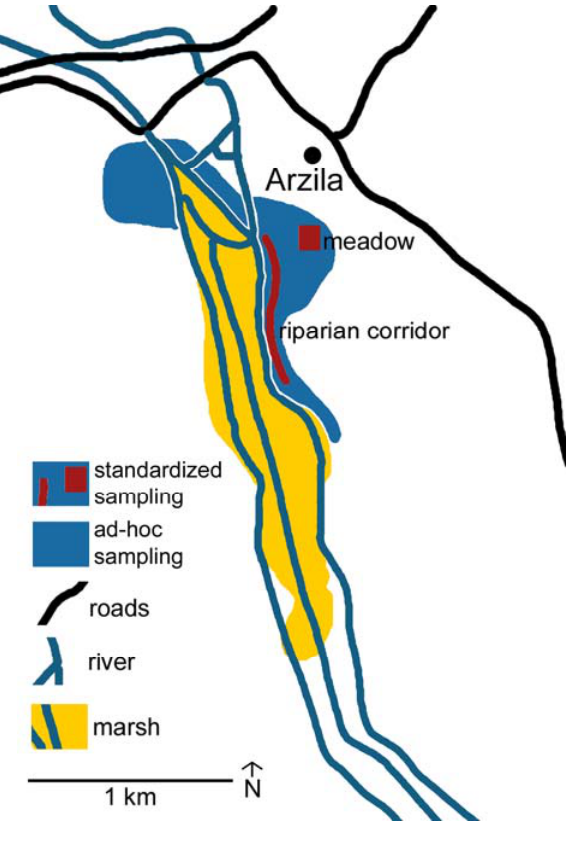
Figure 4. Schematic representation of the sampling area, the Marsh of Arzila, in Central Portugal. The two plots sampled with the standardized and optimized protocol COBRA are indicated, as is the area sampled ad-hoc during one and a half